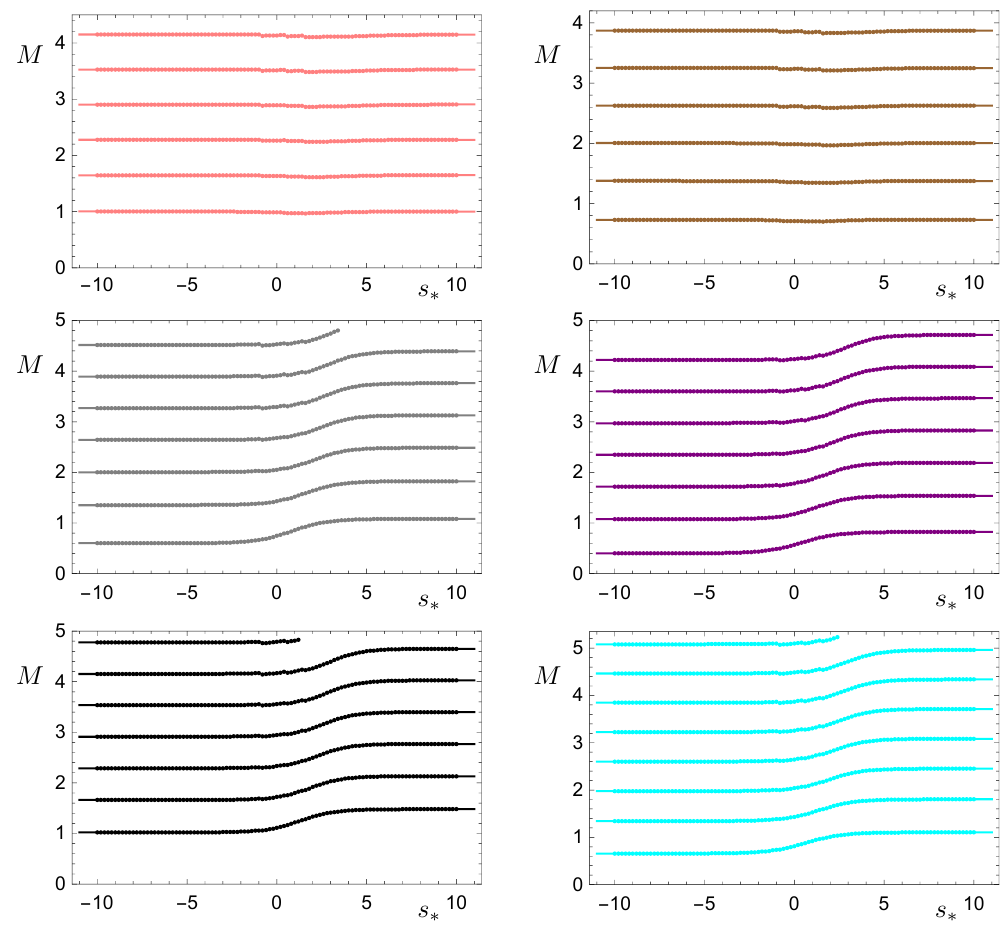
Figure 3 . The spectrum of masses M as a function of the scale s , normalised in units of the mass (cid:3) of the lightest tensor. In all plots, the left and right margins correspond to the spectra computed from the analytical solutions obtained by deforming the six-dimensional critical points. From top to bottom, left to right, the spectra of (cid:13)uctuations of SU(2) adjoint pseudo-scalars (cid:25) i (pink), the SU(2) adjoint vectors A i (brown), U(1) (pseudo-)scalar X obtained as gauge-invariant combination of A 6 (cid:22) and B 65 (grey), the U(1) transverse vector B 6 (cid:22) (purple), the U(1) transverse vector X (cid:22) (black) and the massive U(1) 2-form B (cid:22)(cid:23) (cyan). The numerical calculations are performed by setting the IR cuto(cid:11) to (cid:26) 1 = 0 : 001, and the UV cuto(cid:11) to (cid:26) 2 = 8, and in the midpoint determinant method we set (cid:26) = (cid:3)